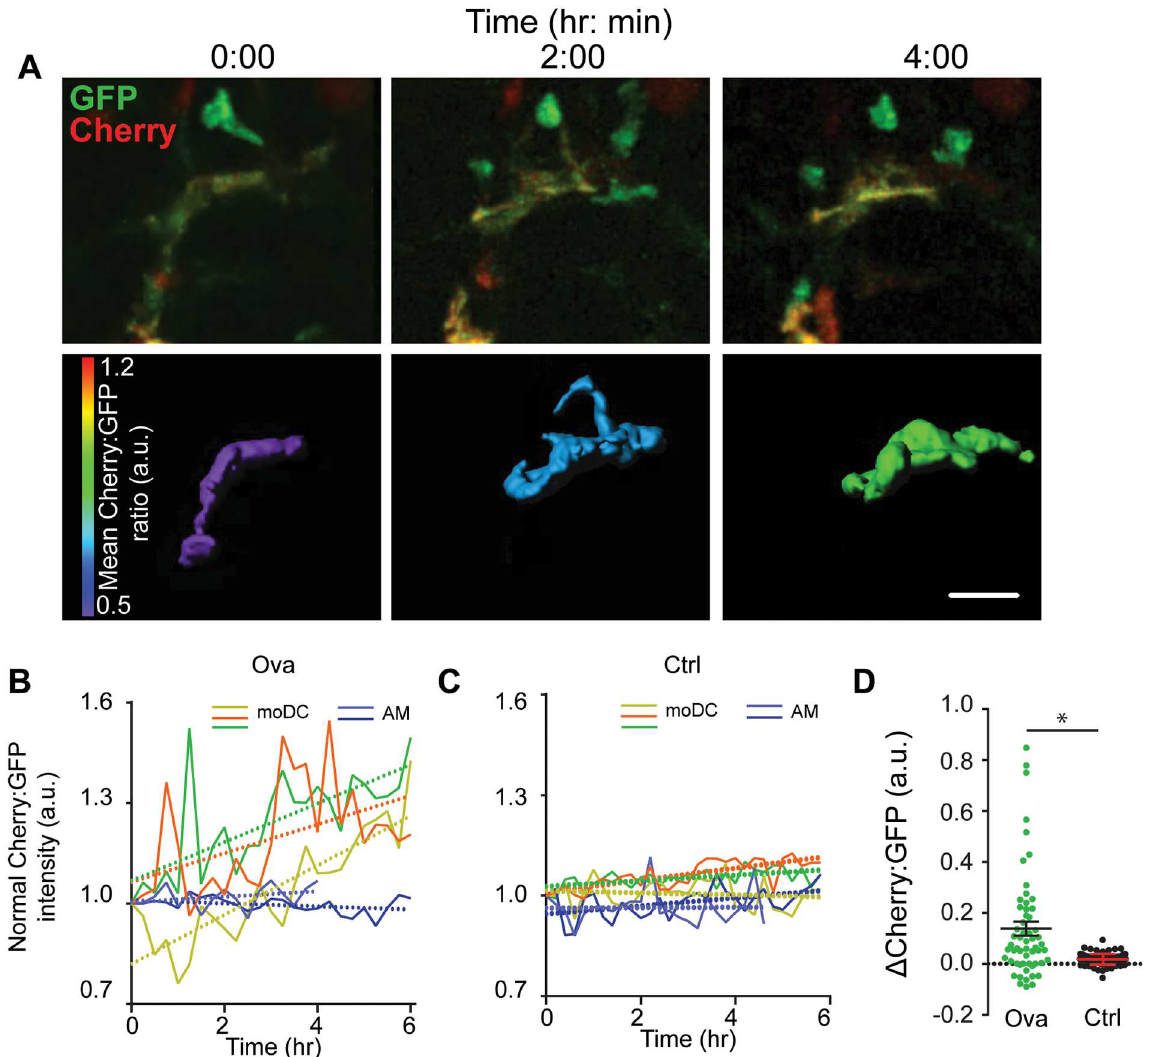
Fig 4. In situ maturation of CX3CR1 + monocyte-derived cells within inflamed lungs. ( A ) Two-photon micrographs at three selected time points demonstrating in situ upregulation of the mCherry signal and thus advancement in red/greenratio. Top row shows an extended myeloid cell, showingCherry (red) and GFP (green) channels. Bottom row shows renderedisosurfacesof the same cells, using a Cherry:GFP ratio-basedcolor scale. Note: 0h is the beginningof imagingon day 24 of ova treatment. Scale bar = 20 μ m. Also see Video 2. ( B ) Cherry:GFP ratio, normalizedto the first frame, for 3 exemplar moDCs along with similar plots for 2 alveolar macrophages (AM) for comparison. Linear fits are shown by dotted lines, Each color represents an individualcell. ( C) Similar plots for three cells taken from control lungs, also compared to exemplar AMs and showingreduced in situ maturation. ( D ) Plots of change in Cherry:GFP ratio normalizedto AM intensity and time, for multiple cells studied in OVA-challenged and control lungs showingstatistically significant p < 0.05 differences in allergic lungs as compared to control. Data represent 3 independent